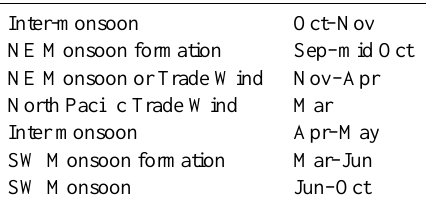
Table 2. Seasons of the Philippines, adapted from Williams et al. (1993).